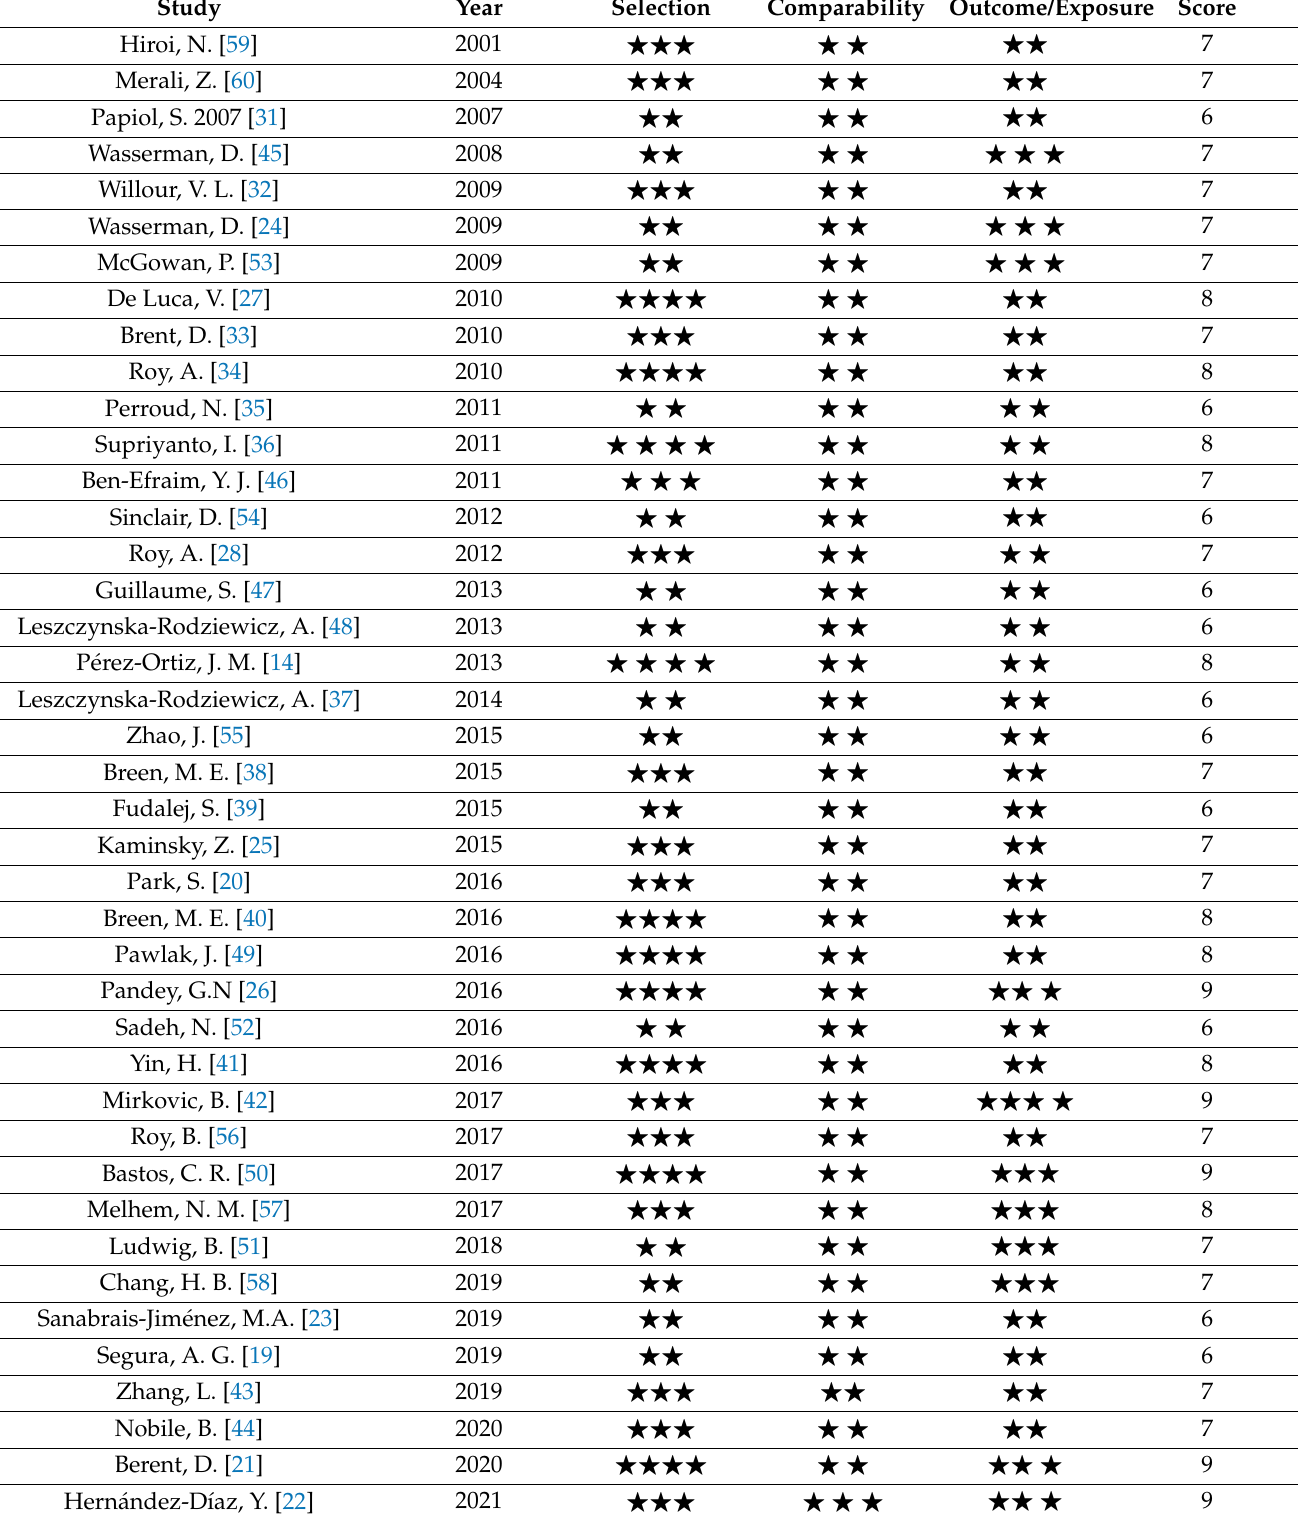
Table 3. NOS scores of 41 studies included in the systematic